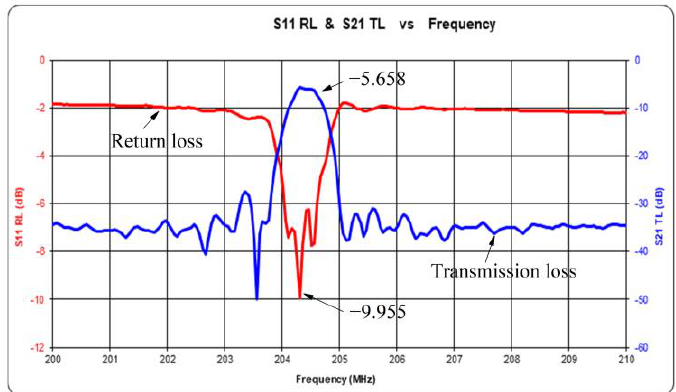
Figure 8. Return loss and transmission loss.